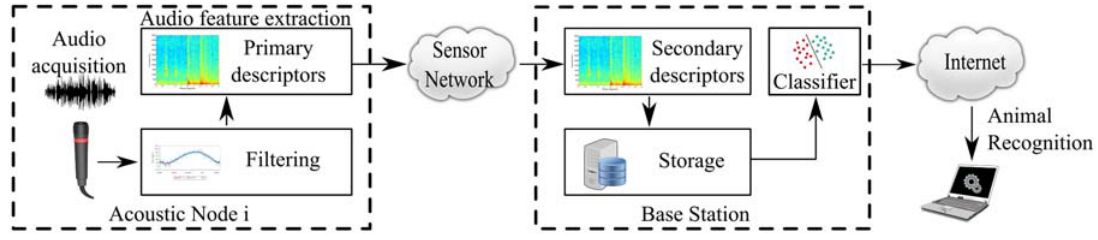
Figure 4. Processing architecture of the system.